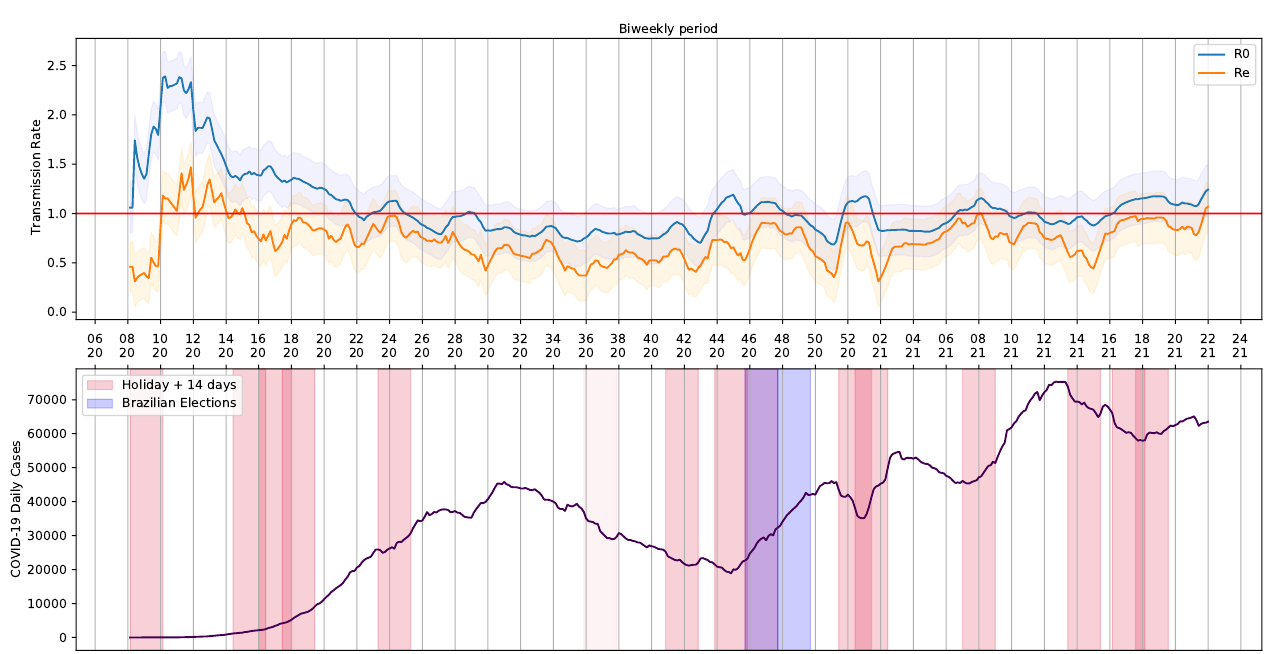
Figure 8. Basic Reproduction Number R 0 and COVID-19 Daily Cases in Brazil.